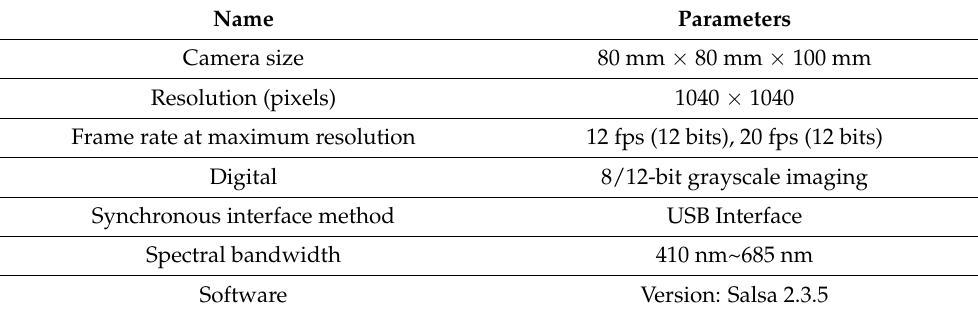
Table 2. SALSA imager